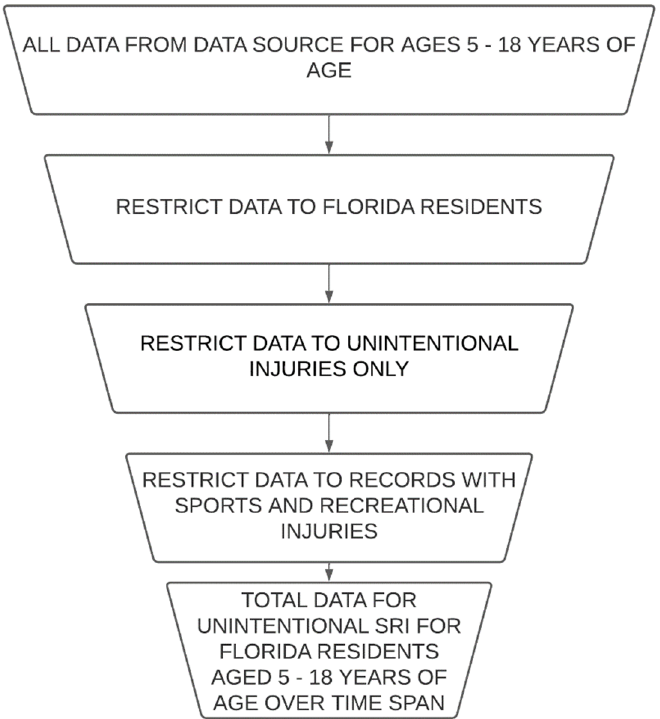
Figure 2: Obtaining a study population from the database population in the longitudinal sports and recreation injury